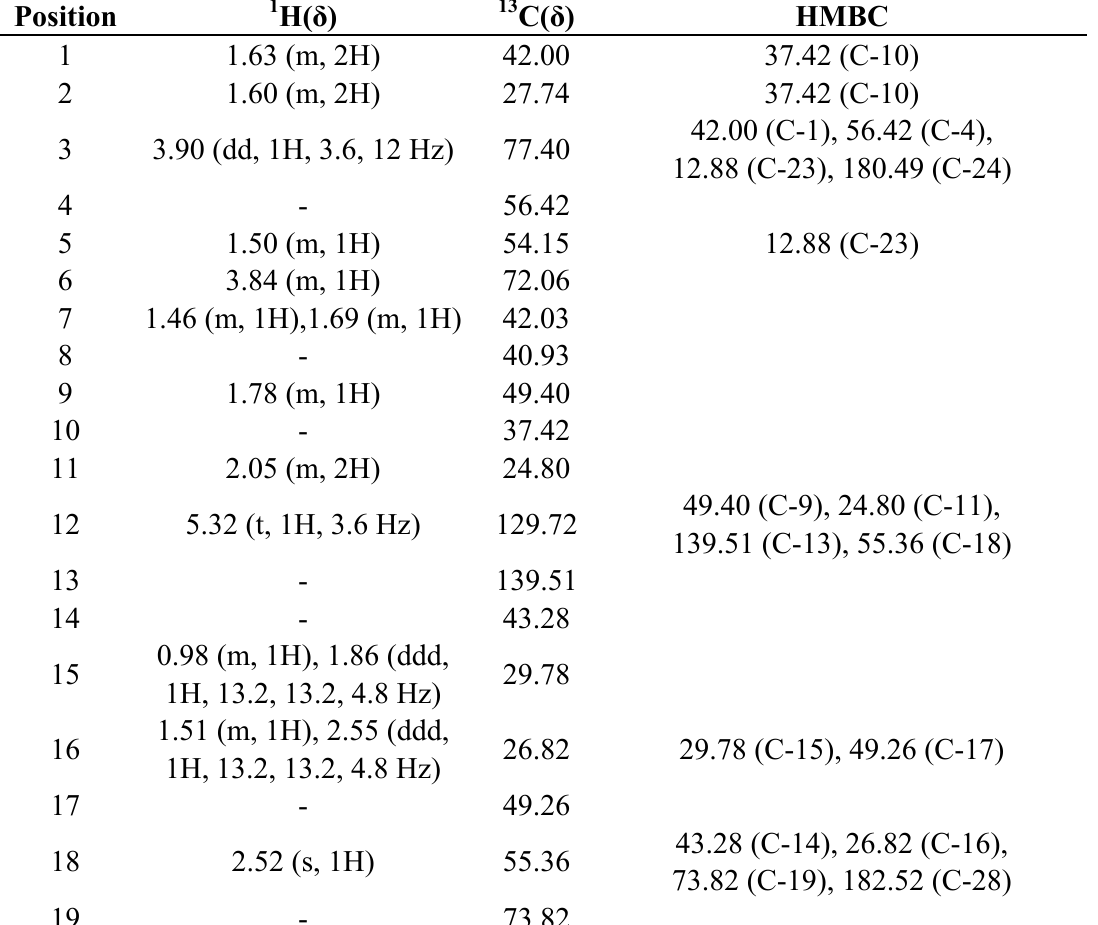
Table 1. 1 H-NMR and 13 C-NMR data for 1